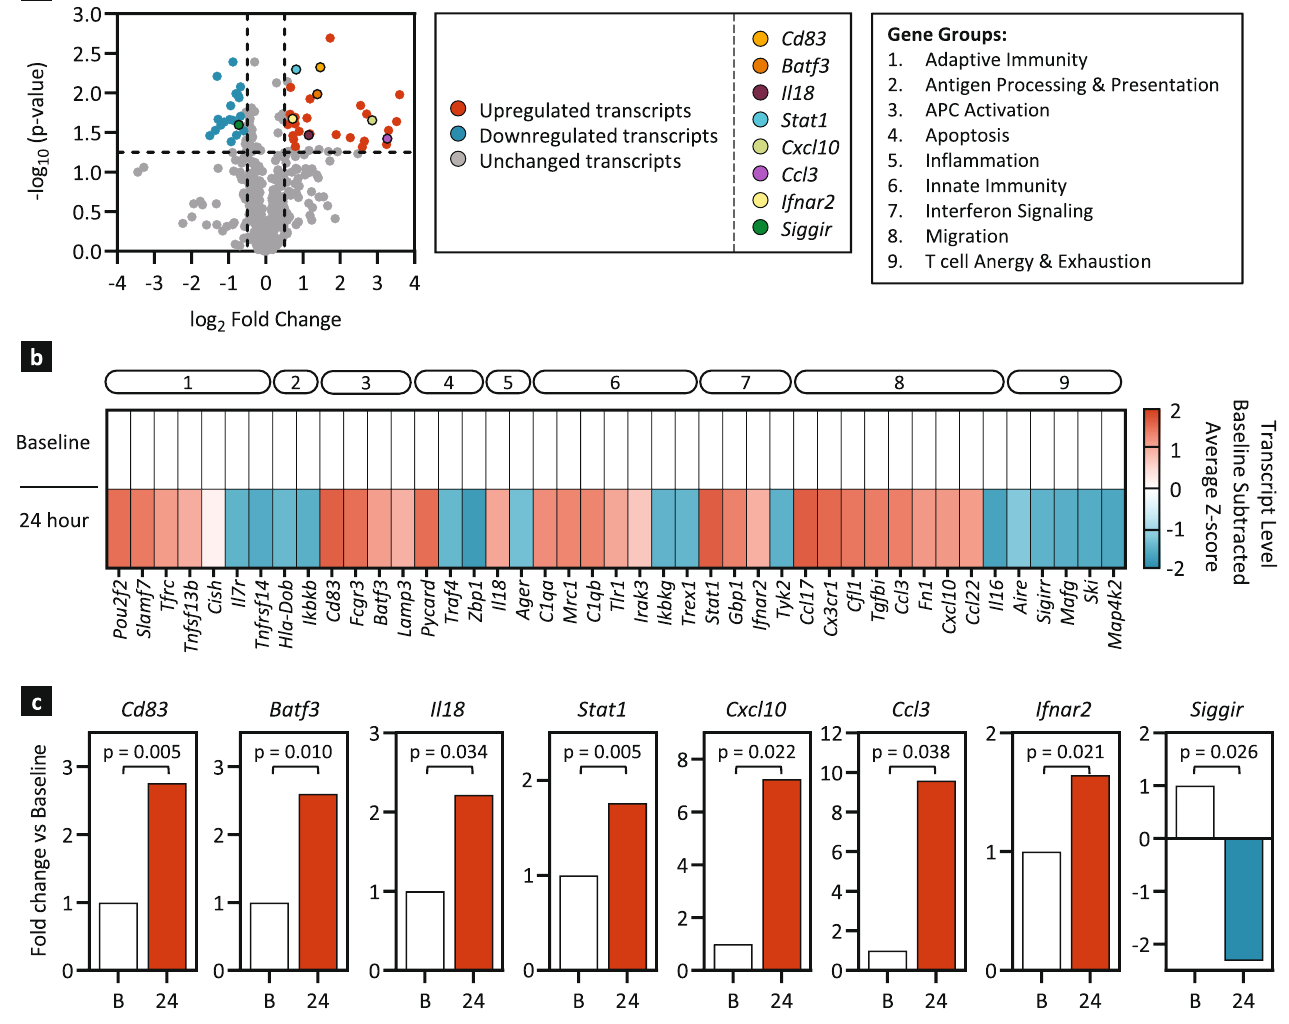
Fig. 7 AMP-CpG immunization stimulates dynamic changes in immune gene transcript levels in NHP draining lymph nodes. Rhesus macaques ( n = 3) were immunized at week 0, 4 and 10 with 140 µg WH-01 RBD admixed with 5 mg of AMP-CpG. Lymph node FNAs were collected at baseline and 24 h post-week 10 boost. Nanostring analysis, using the NanoString nCounter ® NHP Immunology Panel, was performed comparing gene expression in lymph node FNA between baseline and 24 h post boost. a Volcano plot representation of log- transformed transcript values of 770 genes at 24 h. Dotted horizontal line represents signi fi cance threshold of p = 0.05 (determined with Rosalind software); vertical dotted lines represent fold-change limits of ±1.5-fold change. b Heat map of gene transcripts that were differentially expressed. Shown are mock-subtracted, average Z-scores of gene transcript levels signi fi cantly ( p < 0.05, as determined with Rosalind software) downregulated ( ≥ − 1.5-fold change, blue) or upregulated ( ≥ 1.5-fold change, red) relative to baseline values. Insigni fi cant values with p ≥ 0.05 are shown in gray. Genes were clustered into 9 groups (box insert) using Gene Ontology databases and annotated at the top of the heat map: (1) adaptive immunity, (2) antigen processing and presentation, (3) APC activation, (4) apoptosis, (5) in fl ammation, (6) innate immunity, (7) interferon signaling, (8) migration, and (9) T cell anergy and exhaustion. c Fold-change bar graphs for selected gene transcripts. Statistical analysis was performed using Rosalind